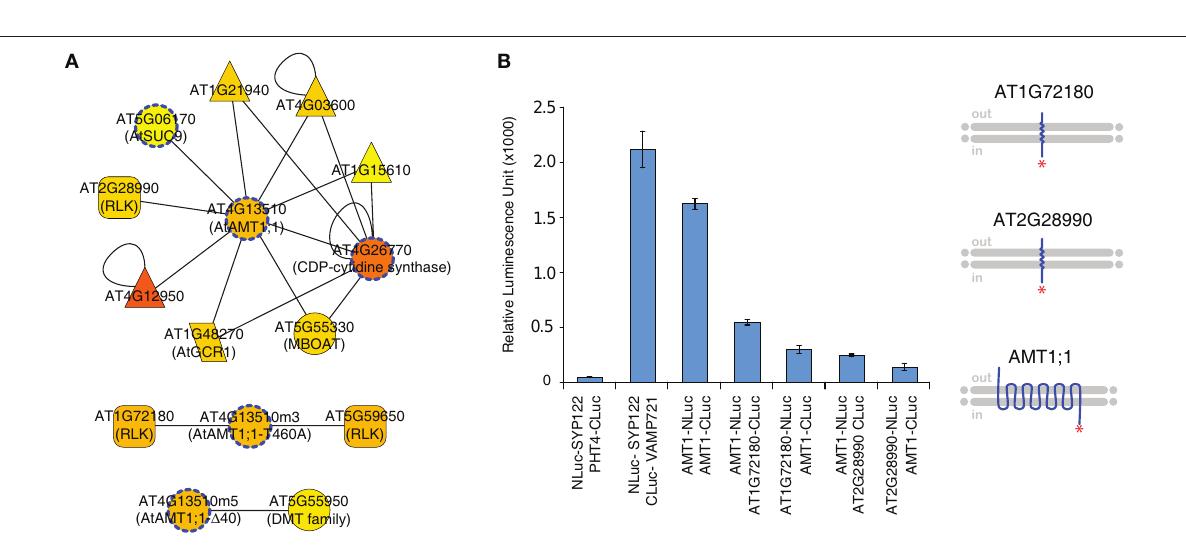
Figure 8 | Ammonium transporter sub-network. (A) AMT1;1 sub-network (AT4G13510). Labeling as in Figure 5 . (B) Independent analysis of AMT1;1 interaction with two RLKs identified in AMPv2 using the split luciferase assay in Arabidopsis leaf protoplasts. Red asterisks in the diagram to the right indicate the position of the split luciferase